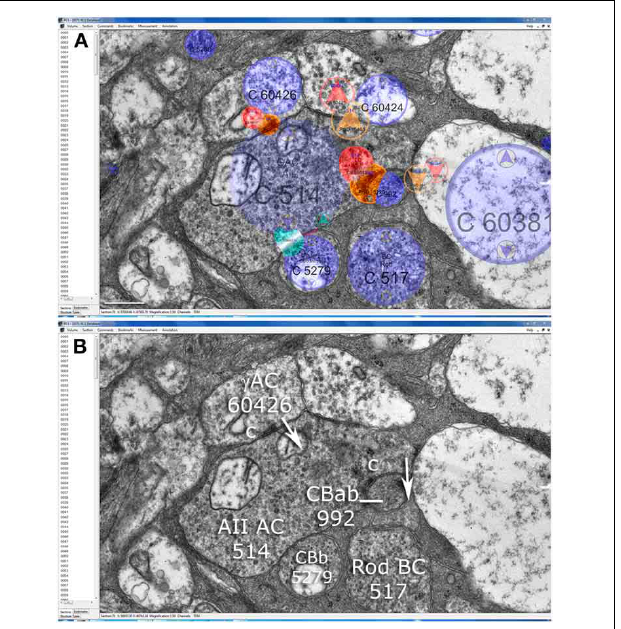
FIGURE 5 | Synaptic patterns of AII cell lobules in the Viking connectome viewer. (A) Slice z71 showing annotation overlays for cells (blue), presynaptic elements (red), postsynaptic elements (orange) and touches (cyan). (B) A lobule from AII cell 514 is presynaptic to OFF cone bipolar cell CBab 992, postsynaptic to GABAergic amacrine cell ( γ AC) 60426, and touches ON cone bipolar cell CBb 5279 without making any other specialization. Scale (A) ,